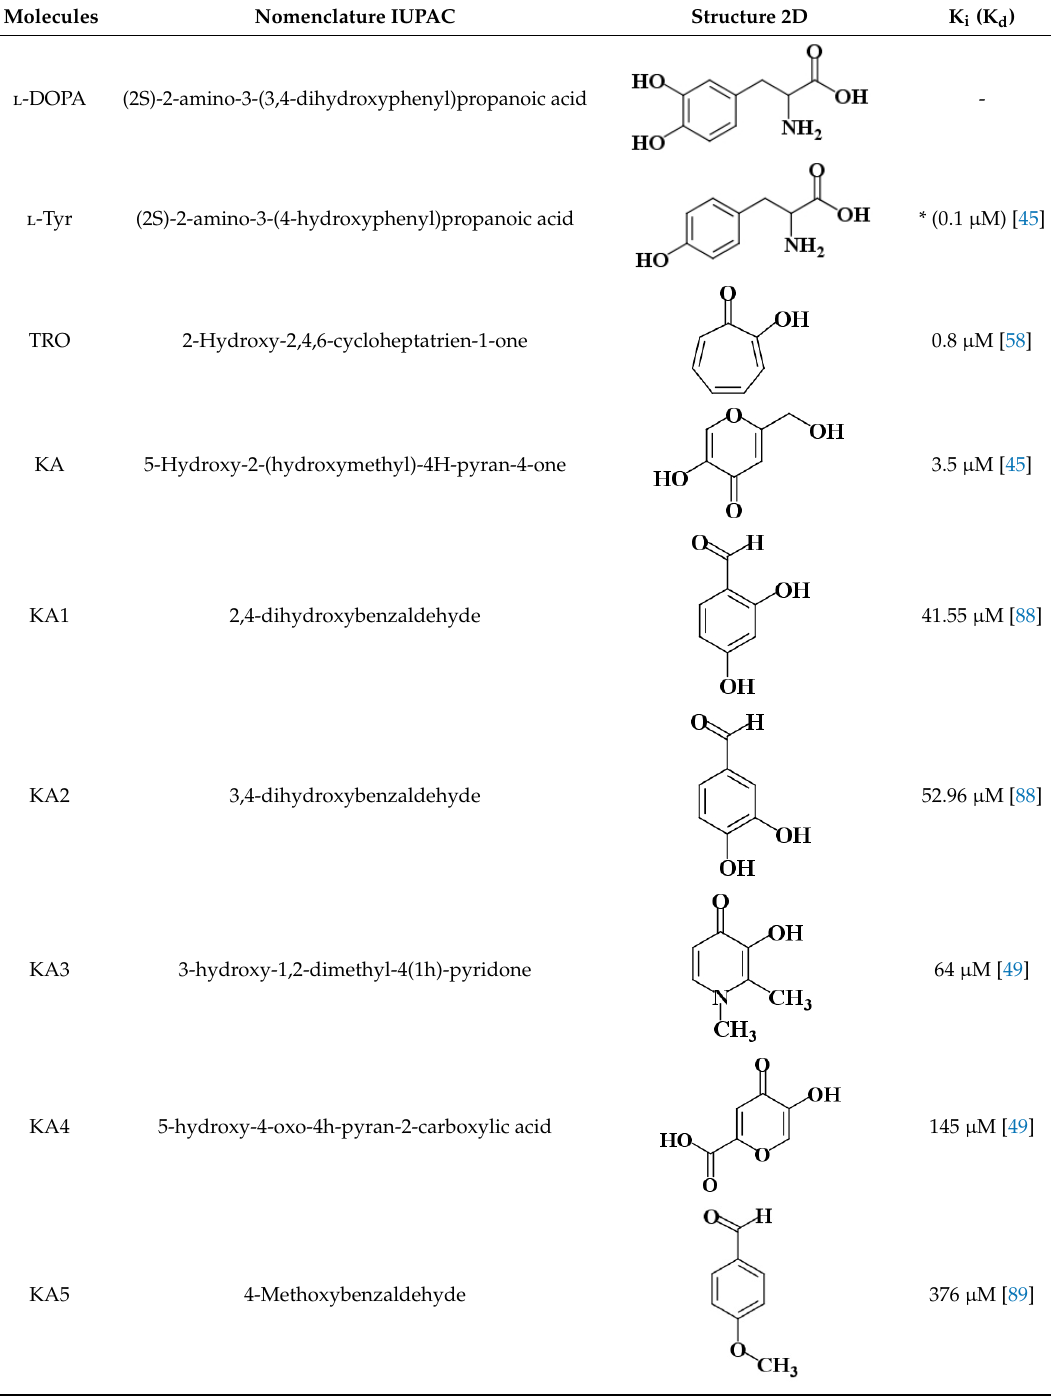
Table 6. Experimental inhibition (K i ) and dissociation (K d ) constants for Tyrosinase (TYR) ligands.